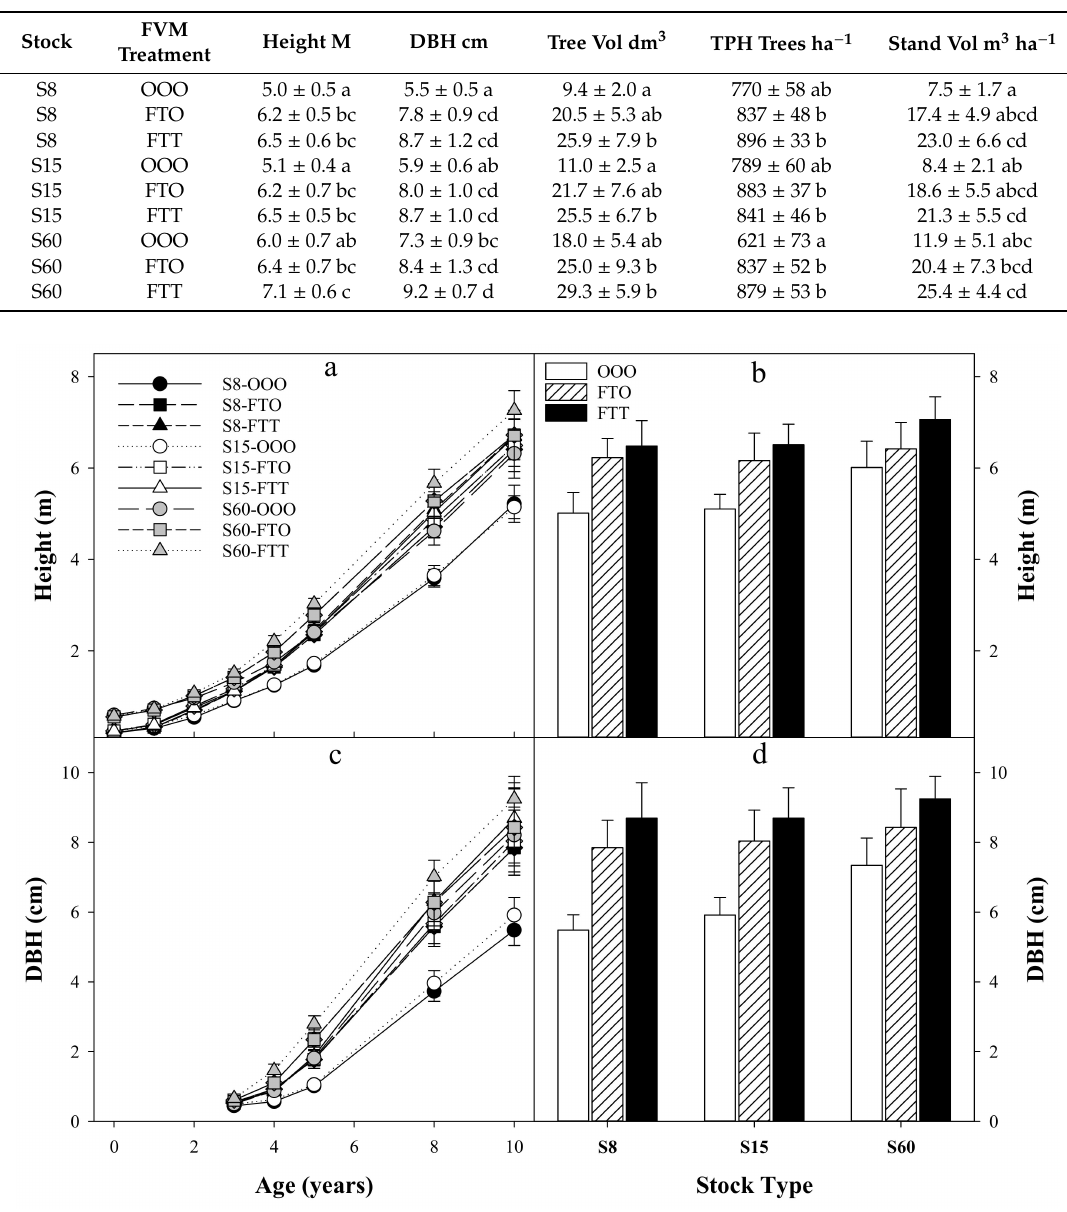
Figure 4. E ff ect of stock type and vegetation management regime on Douglas-fir: ( a ) mean height over time, ( b ) mean height at year 10, ( c ) mean diameter at breast height (DBH) over time, and ( d ) mean DBH at year 10. Treatment descriptions are provided in Table 1 and treatment comparisons are provided in Table